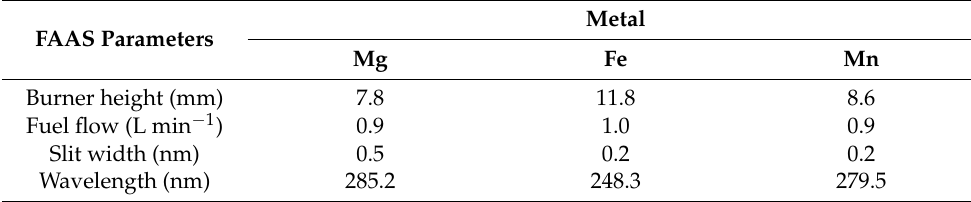
Table 2. Optimized FAAS instrumental parameters to determine Mg, Fe, and Mn. FAAS